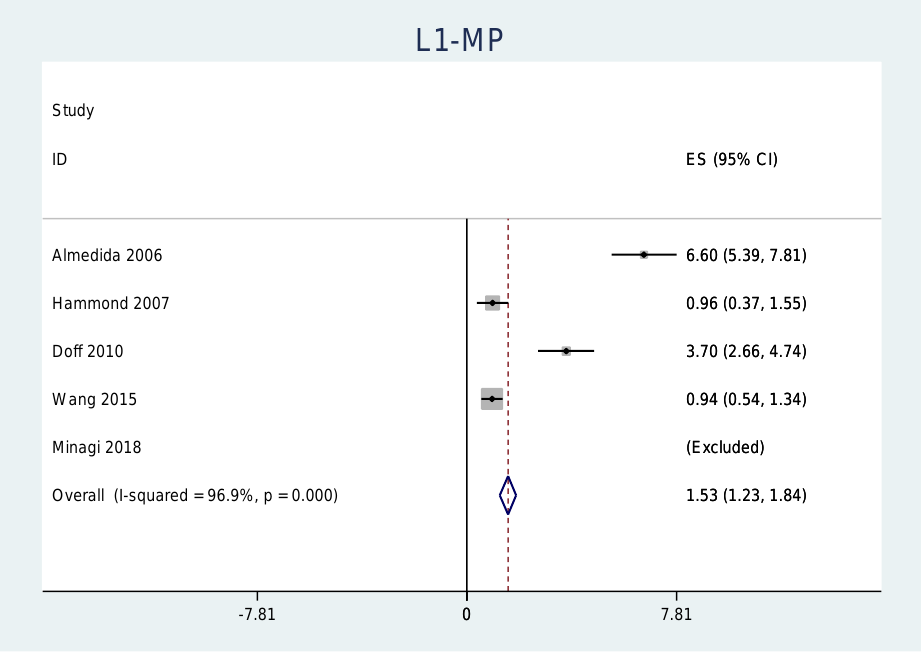
Figure 7. Forest plot of the results of L1-MP changes using the random-effects model.